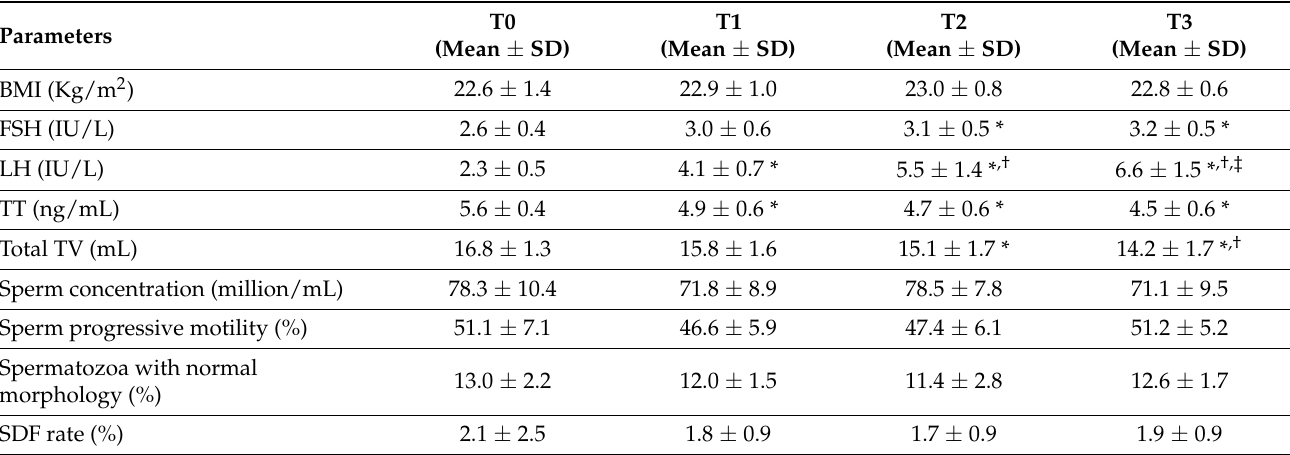
Table 1. Trend over time of anthropometric, hormonal values, testicular volume, sperm parameters, and sperm DNA fragmentation in patients with III degrees bilateral